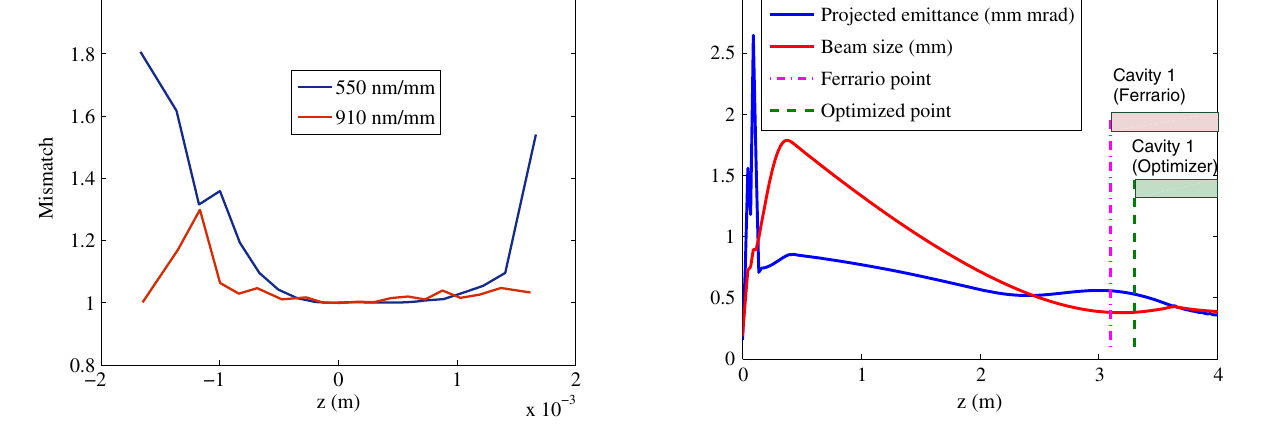
FIG. 7. Mismatch along the bunch for the optimized layout of the PSI gun SwissFEL injector. The optimizations are performed assuming 910 nm = mm and 550 nm = mm for the normalized intrinsic emittance.